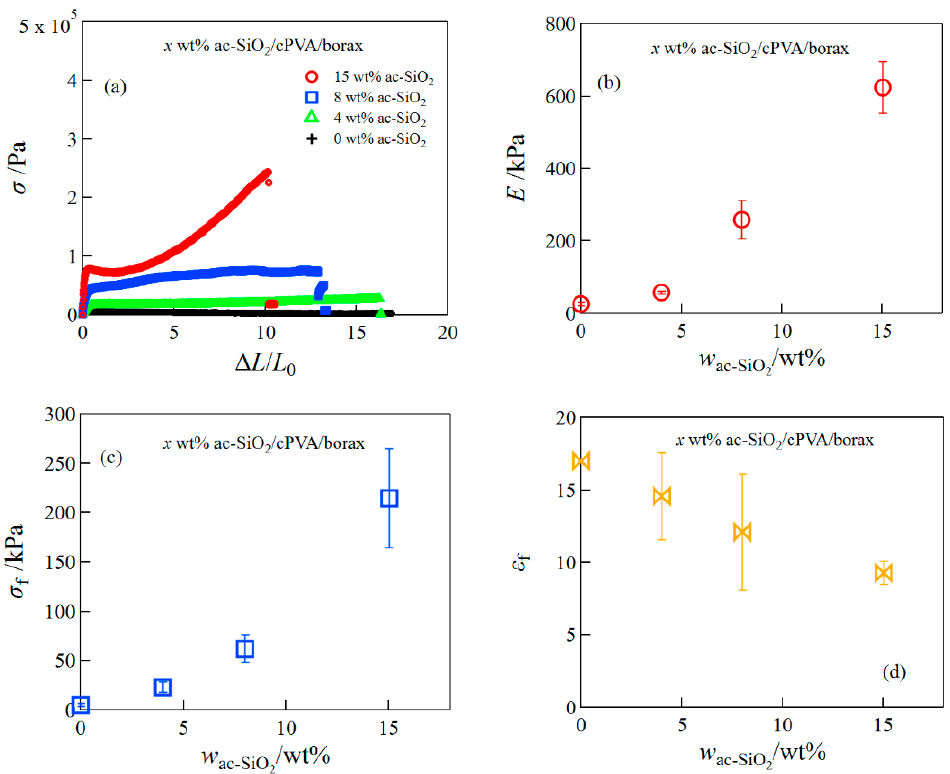
Figure 2. Tensile stress–strain curves ( a ), the Young ′ s modulus ( b ), fracture stress ( c ), and fracture strain ( d ) for ac-SiO 2 /cPVA/borax hydrogels.